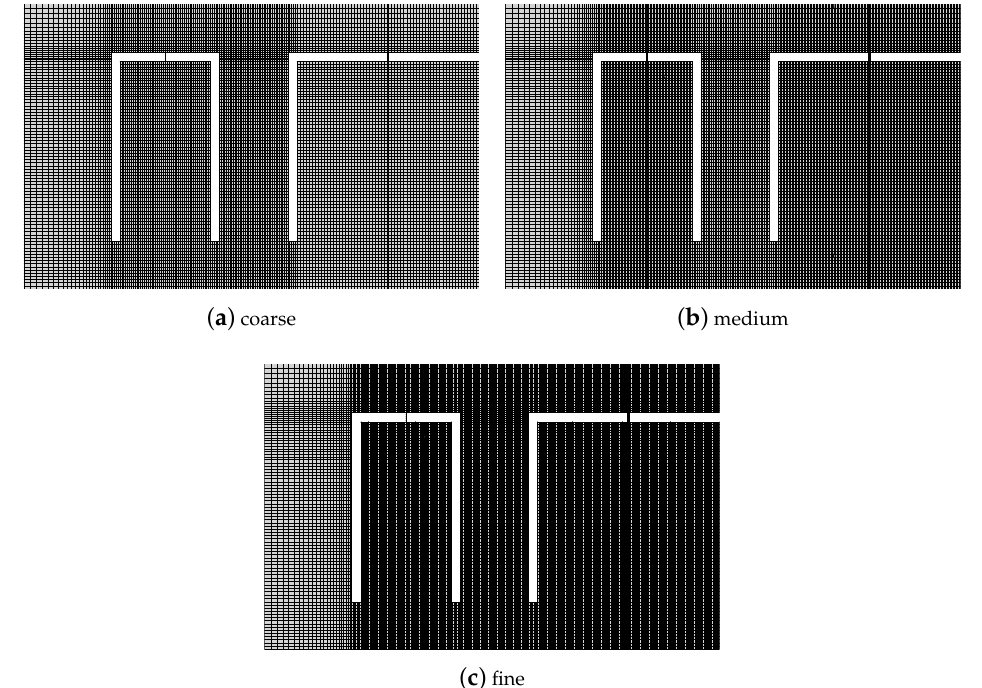
Figure 8. Different spatial resolutions around the dual-OWC system.